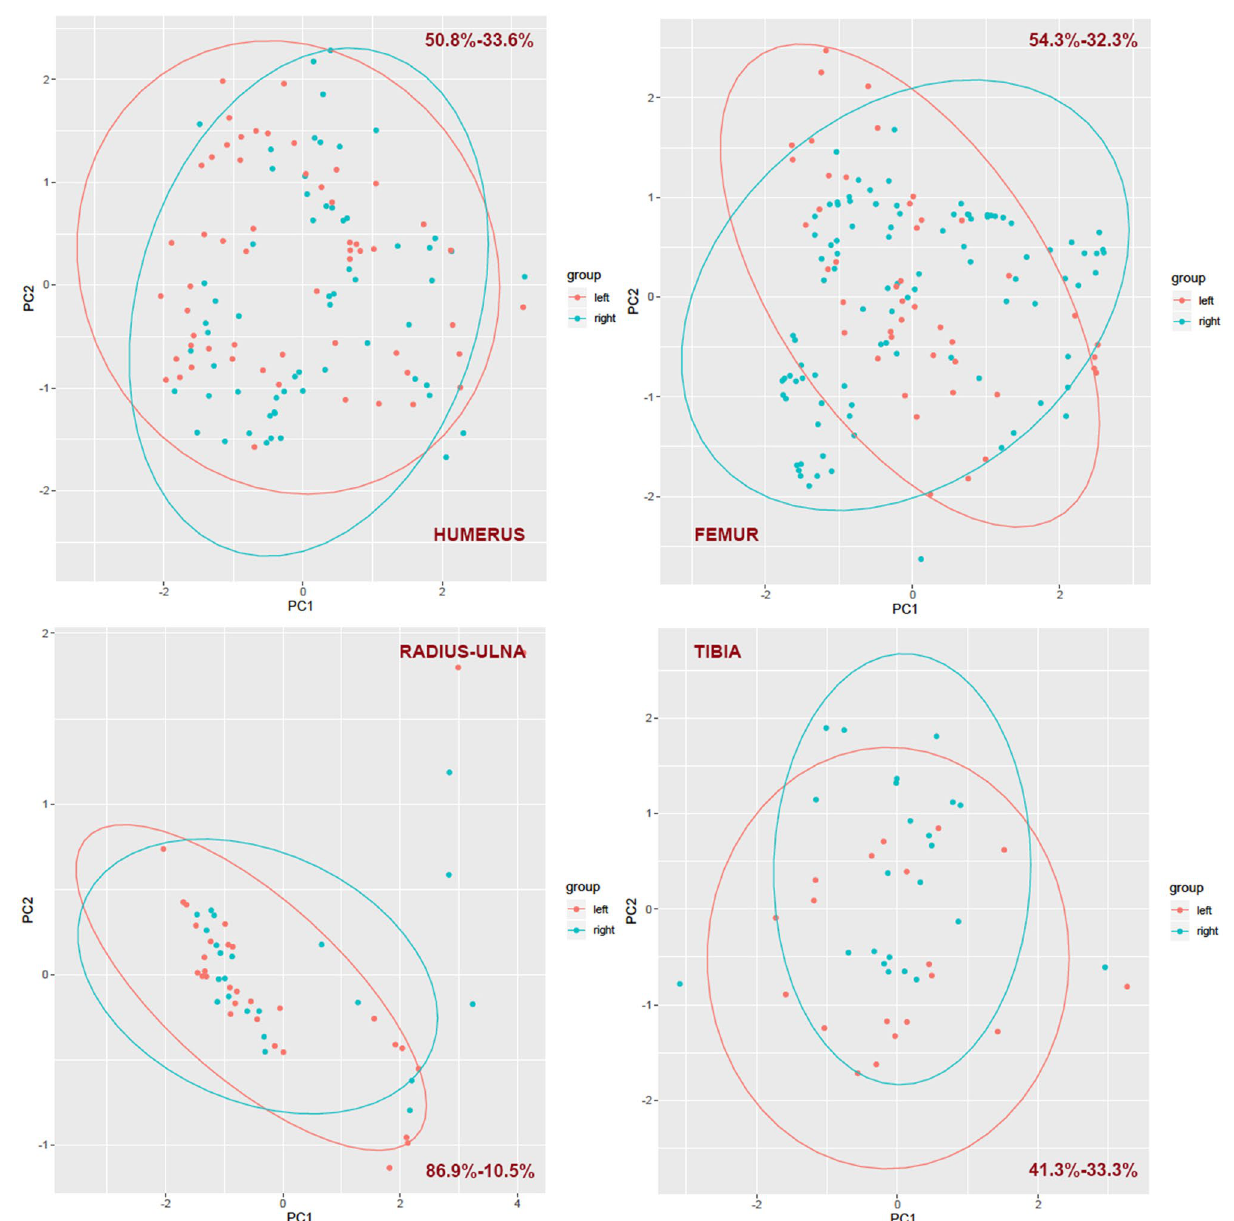
Figure 4. Principal component analysis (PCA) of each of the four long bones (humerus, femur, radius- ulna and tibia) according to side (left–right) showing point distribution according to components generated by compressing the three-dimensional coordinates. A 95% confidence ellipse per side shows variation and similarity of toothmark patterns in each of the bones. Percentages shown are for the first and second component Right tibiae are only slightly more toothmarked than the left tibiae. Given its overall greater length than other long bones, its low toothmarking frequencies renders them the least impacted elements in number of tooth marks. Most marks cluster on the proximal end, more specifically, on the tibial crest. The lateral side is more damaged than the other sides. In the whole collection, only one tooth mark was found in the distal half of the shaft (Fig. 2). Again, most of the damage on the caudal side was concentrated on the proximal lateral side, coinciding with the more intensive damage on the lateral portion of the cranial side. The second-order functions suggest also a very minor clustering trend, slightly more marked than on left tibiae, probably because all tooth marks documented concentrate on the proximal half of the element (Fig. S10). In sum, tibiae show some of the least intense point processes resulting from toothmarking by lions on long bones. Marks occurring on the shaft are usually isolated and more random than on other elements, where they are more spatially recurrent.